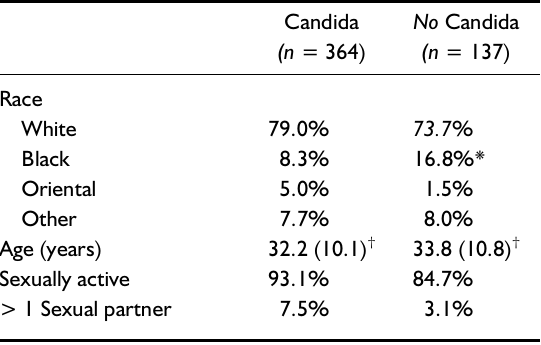
Table 4 Signs and symptoms of women with vulvo- vaginitis positive and negative for Candida by culture